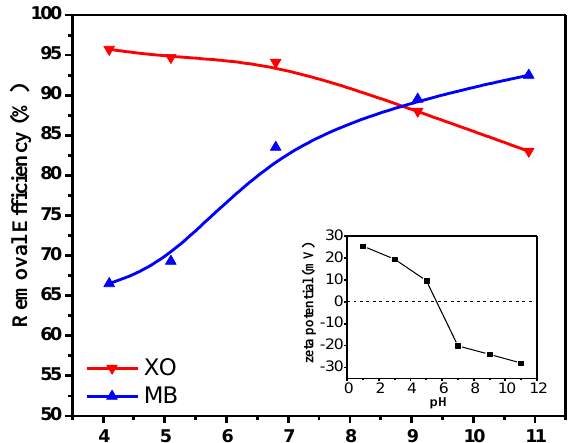
Figure 5. Effect of pH on the dye removal efficiencies of XO and MB (initial dye concentration: 200 mg · L − 1 , 30 mL dye solution, 70 mg adsorbent).